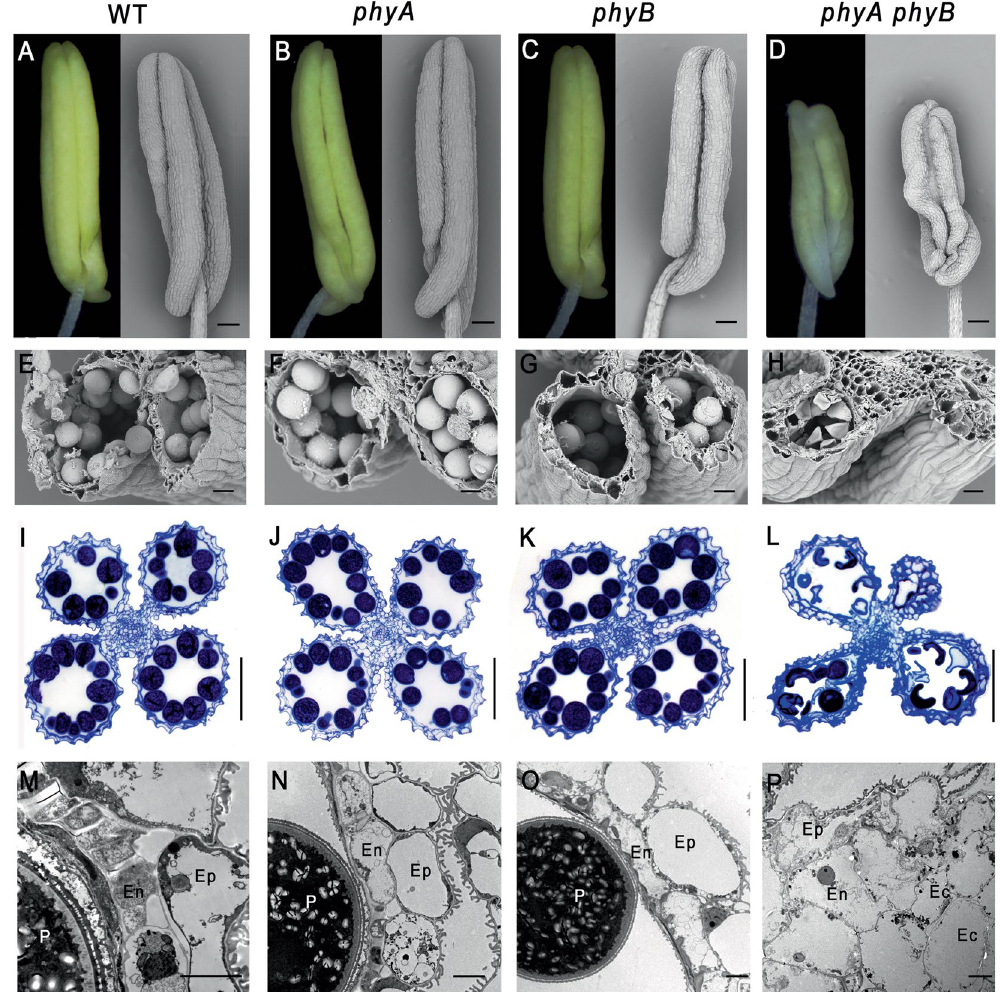
Figure 2. Anthers of phyA and phyB single and double mutants, and wild-type (WT) rice at stage 12. ( A – H ) Light microscopic and scanning electron microscopic analysis of anthers at stage 12. ( I – L ) Sections of anthers at stage 12. ( M – P ) Transmission electron microscopic analysis of anthers at stage 12. Ep, epidermal cell layer; En, endothecium cell layer; Ec, extra cell layer; P, pollen grain. Bars = 0.1 mm in ( A – D ) 20 µ m in ( E – H ) 50 µ m in I–L, 5 µ m in